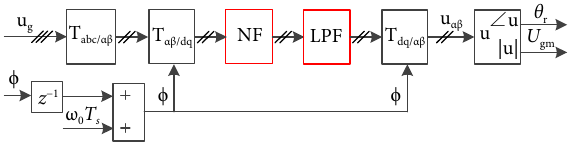
Fig. 6 The grid-voltage sag-depth estimation scheme NF–LPF–N v . voltage recovery. During the LVRT transition, there are multiple paths for regulating the active-power flow of the MVac port, and it should be decided to prevent overcurrent protection.